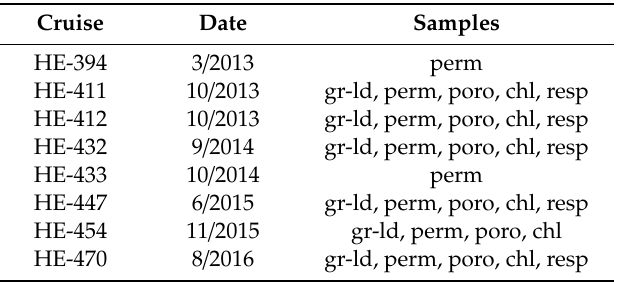
Table 1. Cruises of RV Heincke with contributions to this study. Abbreviations: grain size from the laser di ff raction (gr-ld), permeability (perm), porosity (poro), chlorin (chl), and specific respiration rate